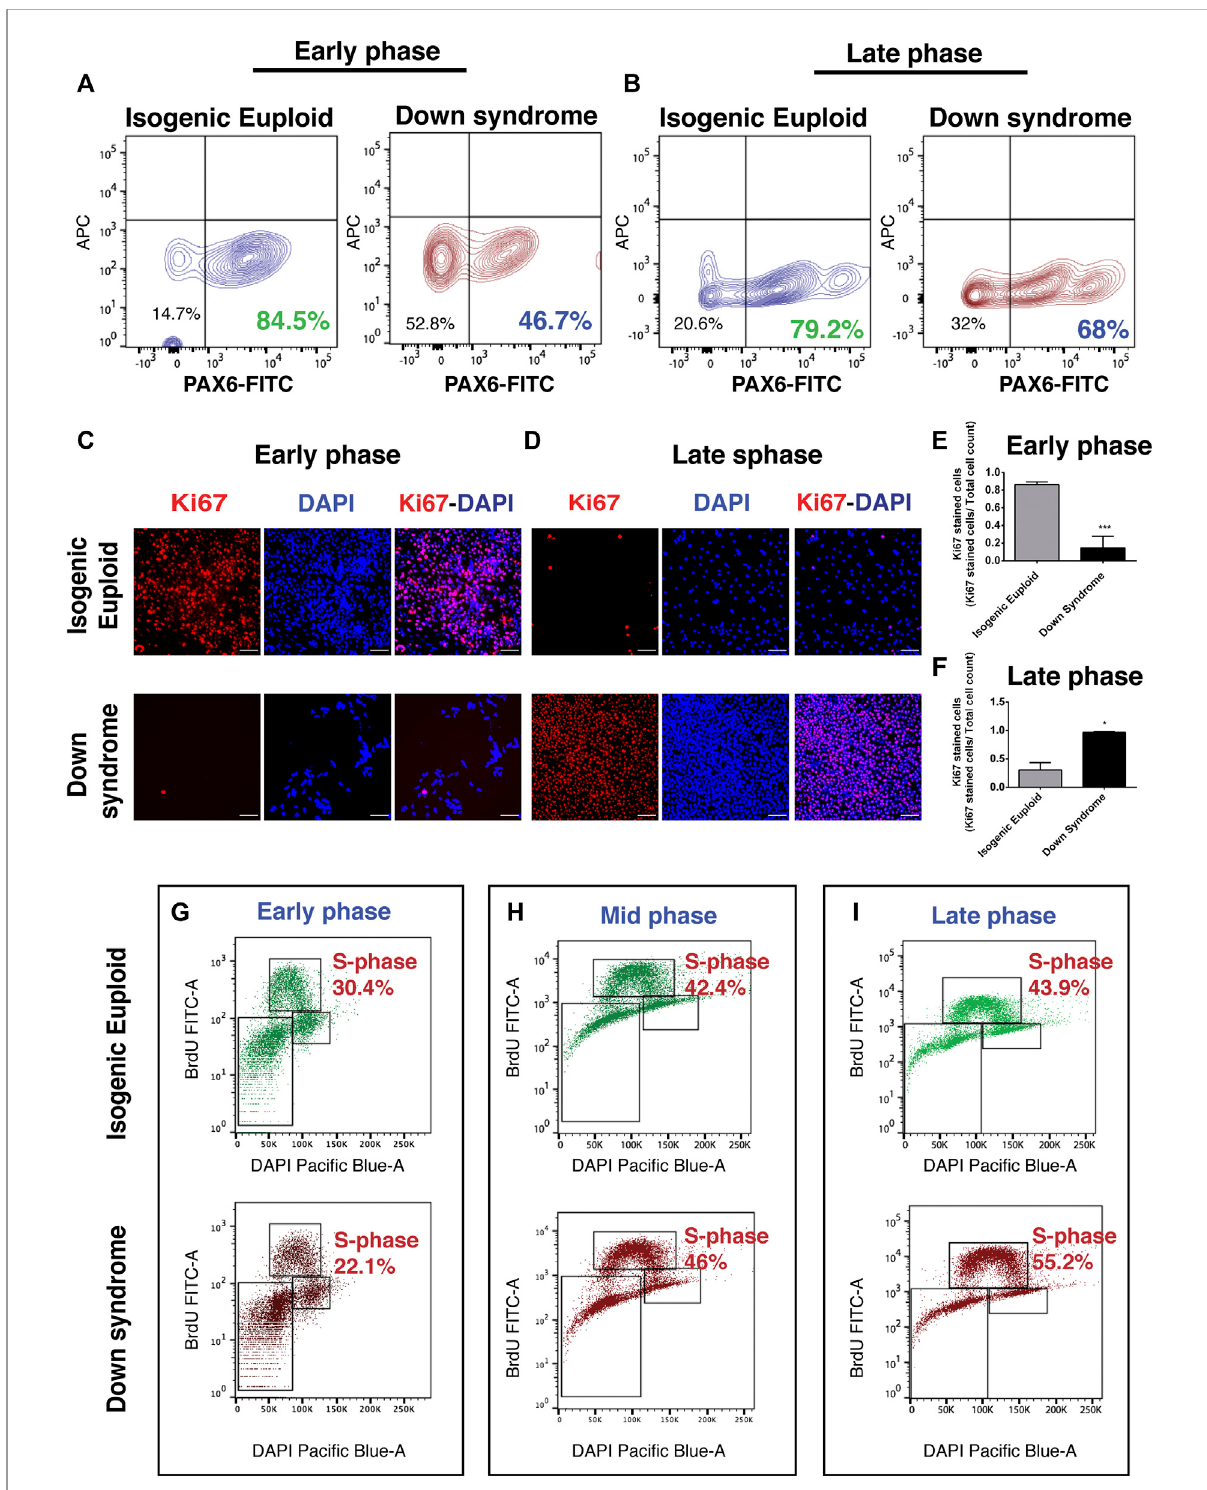
FIGURE 5 Analysis of human neural progenitor cells during neural differentiation. (A) FACS analysis at the early phase (DIV 18) of stage 1 for quanti fi cation of PAX6+ cells. The percentage of PAX6+ cells is shown. (B) FACS analysis at late phase (DIV 28) of stage 1 for quanti fi cation of PAX6+ cells. The percentageofPAX6+cellsisshown. (C) RepresentativeimageofKi67 attheearlyphase(DIV18)ofstage1alongwithcorrespondingDAPIimageand their overlay. (D) Representative image of Ki67 at late phase (DIV 28) of stage 1 along with corresponding DAPI image and their overlay. (E –